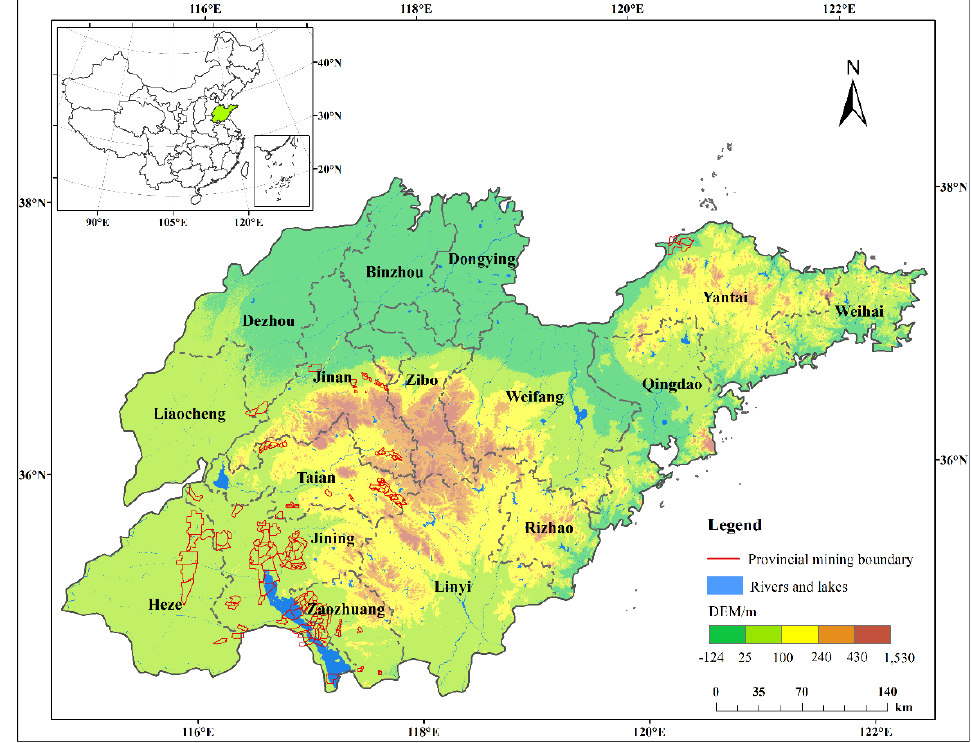
Figure 1. Location and topography of the study area. (The relevant data in the figure comes from Shandong Natural Resources Bureau, Energy Bureau, and mining enterprises.).